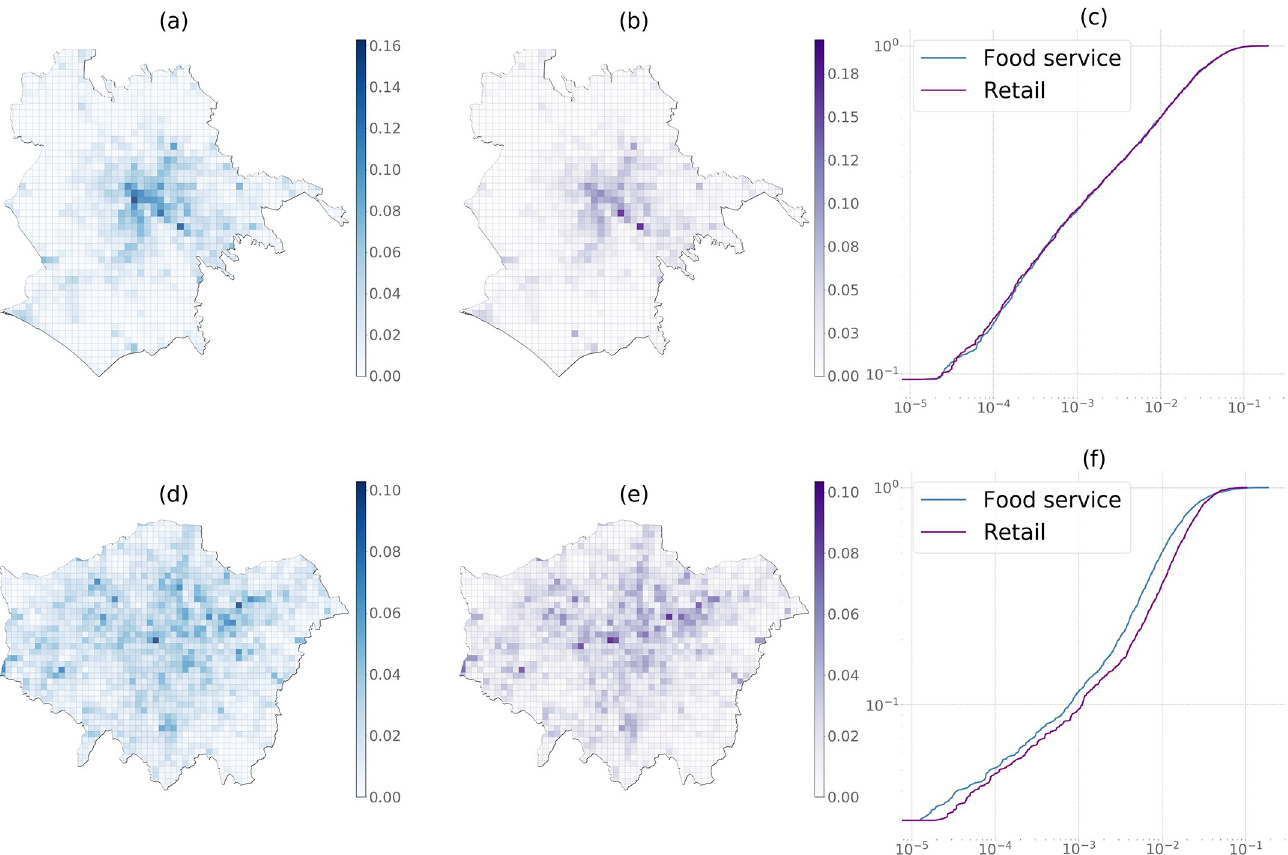
Fig 5. (a)-(b) Food service and retail activity APA distributions in Rome, (d)-(e) in London, (c)-(f) Log-log plots of empirical ECDFs in Rome and London at 12:00pm.